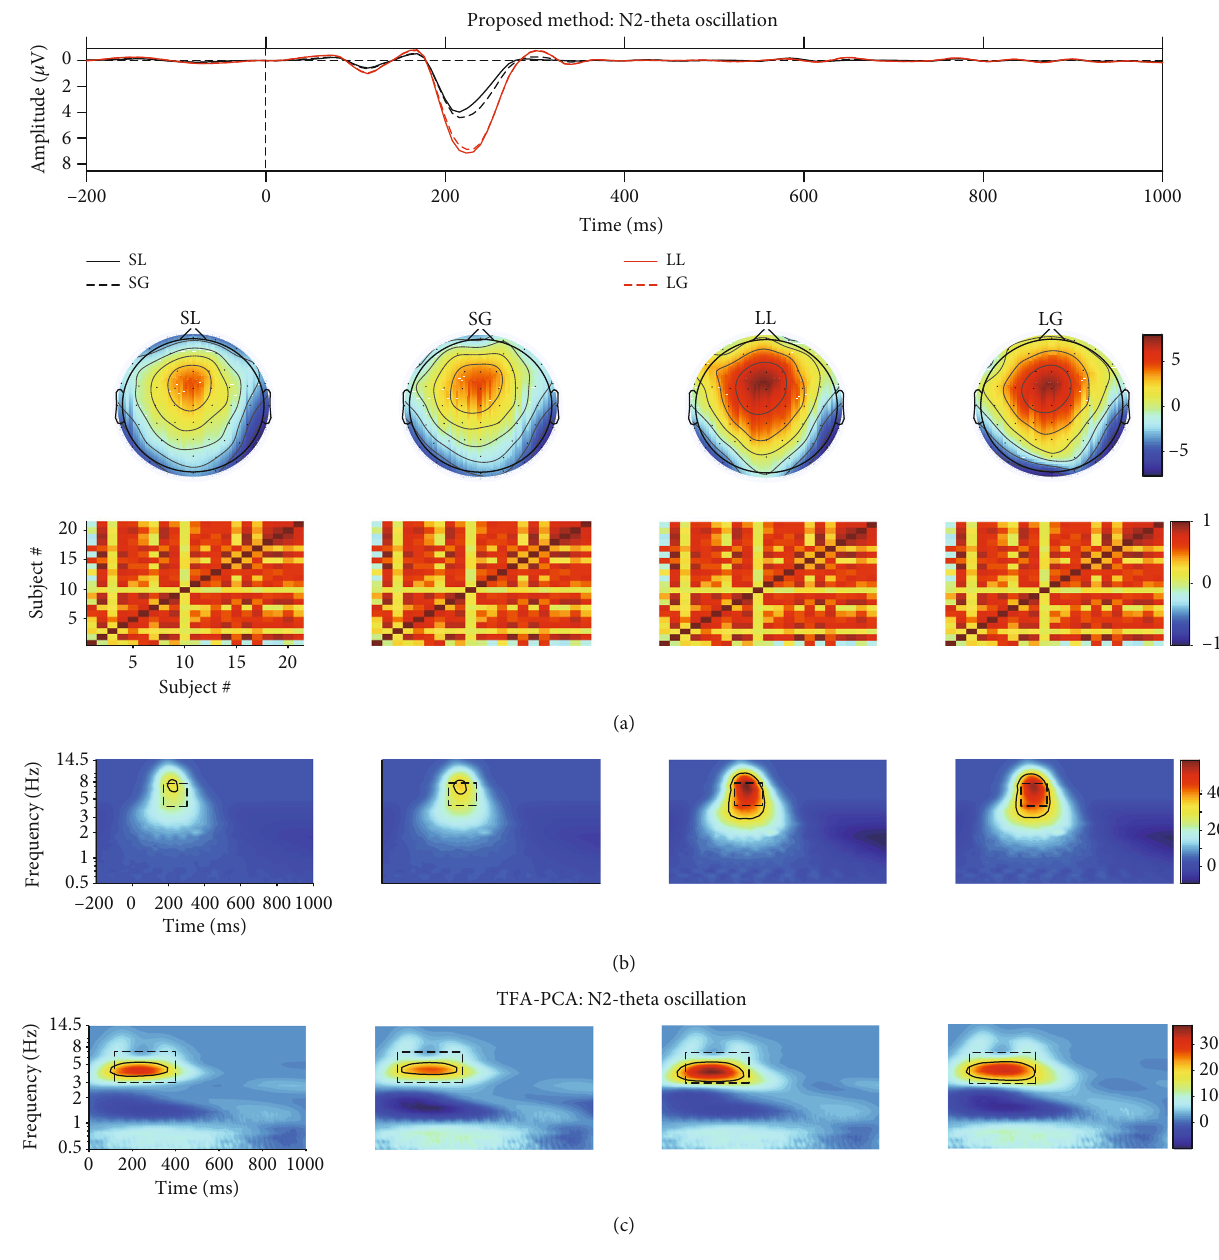
Figure 8: (a) The projected waveform (at Fz, FCz, and Cz electrodes), topography (180-240ms), and similarity of topographies across participants of every condition for N2 which were extracted from the real mixed signal using t-PCA and Promax rotation. (b) The associated grand averaged time-frequency representation (TFR) of every condition for N2-theta oscillation using the proposed approach. The black dotted rectangle (the time window was de fi ned as 150-300 ms, and the frequency range was set as 4-8 Hz, “ R3 ” ) for every condition was marked using the conventional rectangle method, and the other ( “ R4 ” ) was gained by the edge detection algorithm. (c) The weighted N2-theta oscillation by TFA-PCA. The black dotted rectangle was 100-400ms and 3-7Hz ( “ R5 ” ), and the other one ( “ R6 ” ) was gained by edge detection